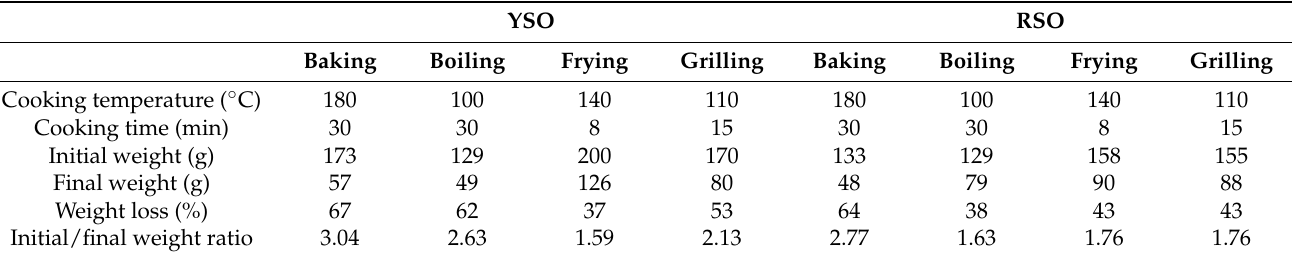
Table 1. Cooking parameters and weight loss during cooking of yellow-skinned (YSO) and red-skinned onion (RSO). YSO RSO Baking